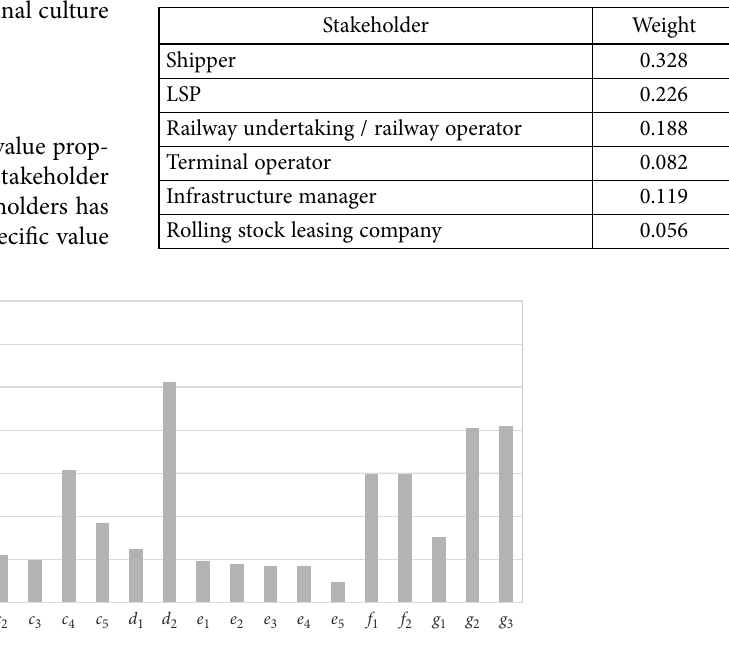
Table 11. Influential weights of stakeholders with respect to innovative value proposition in rail intermodal transport chain